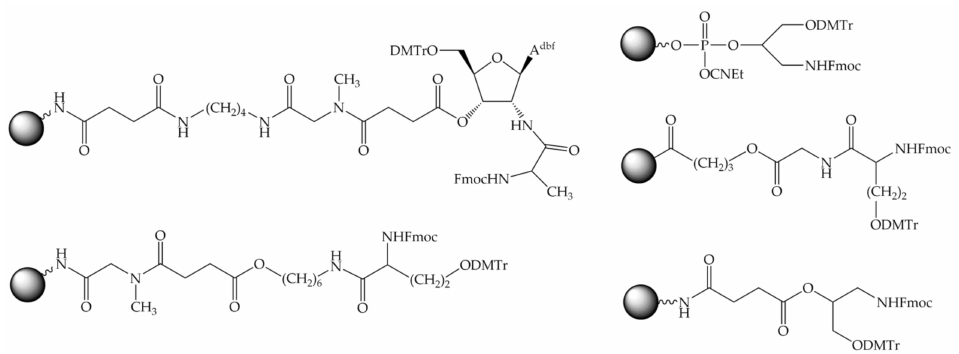
Figure 7. Trifunctional linkers used in the stepwise solid-phase synthesis approach. CNEt—2- cyanoethyl; dbf—di- N , N -butylformamidine.